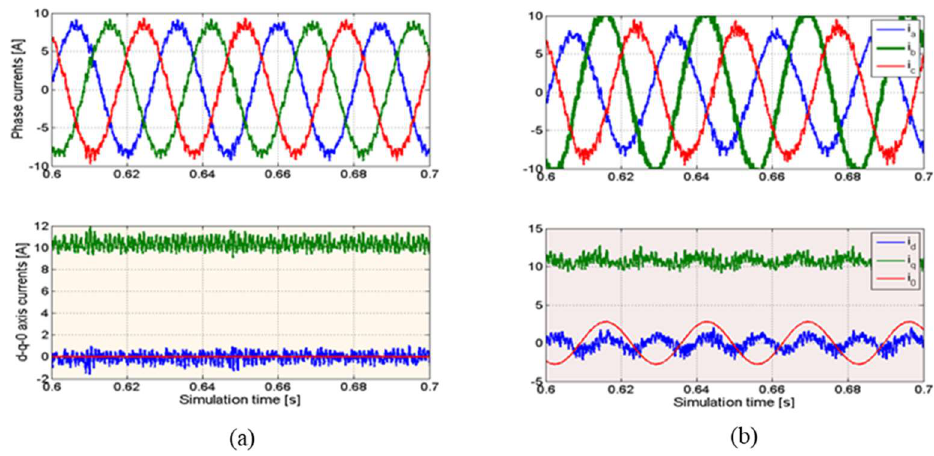
Figure 5. Effect of an occurring turn-to-turn short in a BLAC drive. ( a ) Healthy condition. ( b ) Developing short.